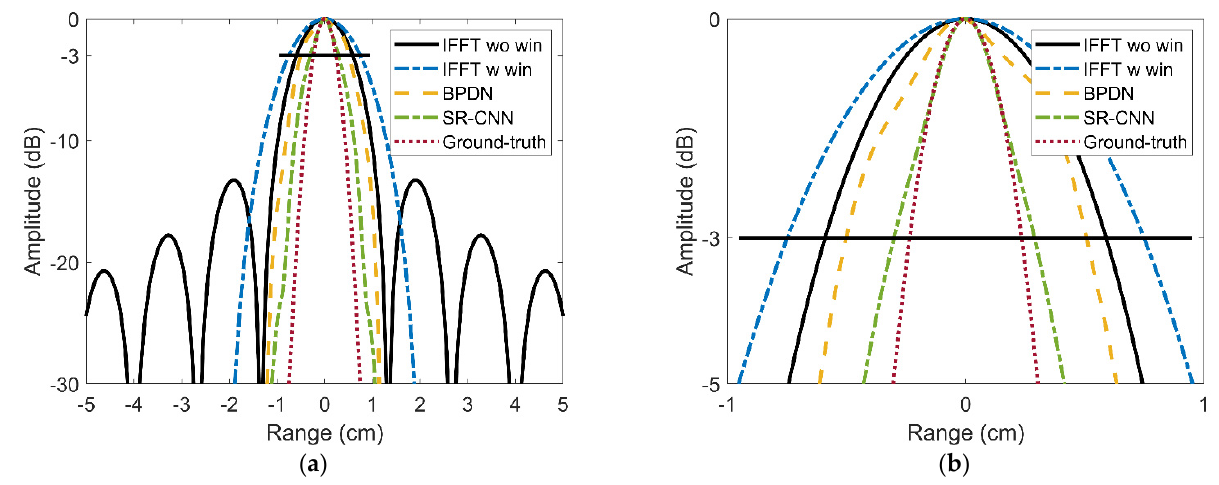
Figure 7. Range profiles of the target imaging result at azimuth 0 m and elevation 0 m. ( a ) Original results. ( b ) Local amplification. Table 1. Comparison of time needs for different methods in two experiments.